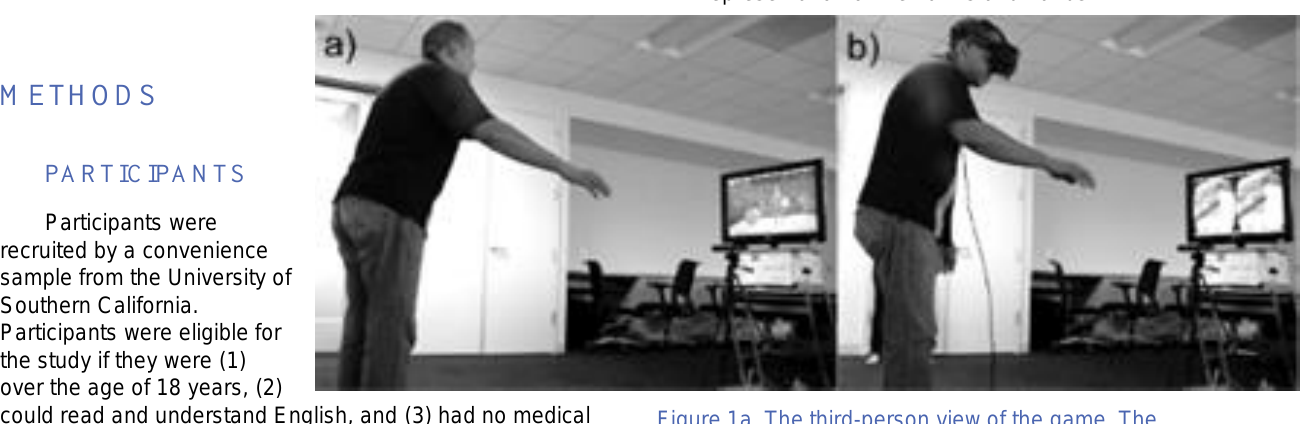
Figure 1a. The third-person view of the game. The participant views the game and avatar on a TV monitor. Figure 1b. The first-person view of the game. The participant views the game through the Oculus Rift® HMD. The view on the monitor is parsed out by the individual